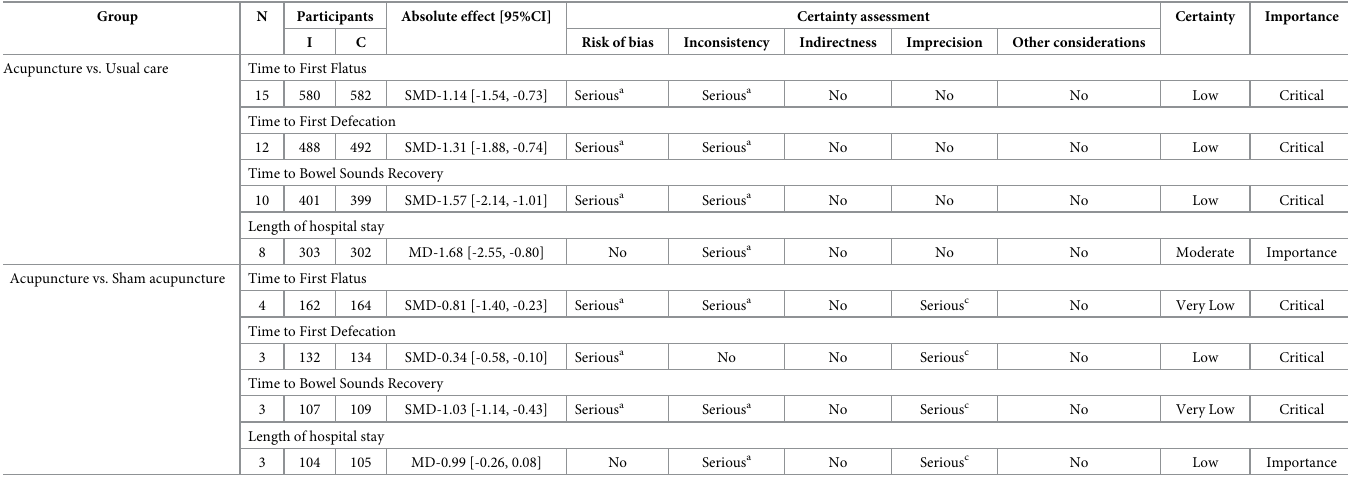
Abbreviations: N, No. of studies; I, intervention; C, control; CI, confidence interval; MD, mean difference; SMD, standard mean difference. a. Downgraded due to serious risk of bias: high risk of performance bias and unclear risk of selection bias and detection